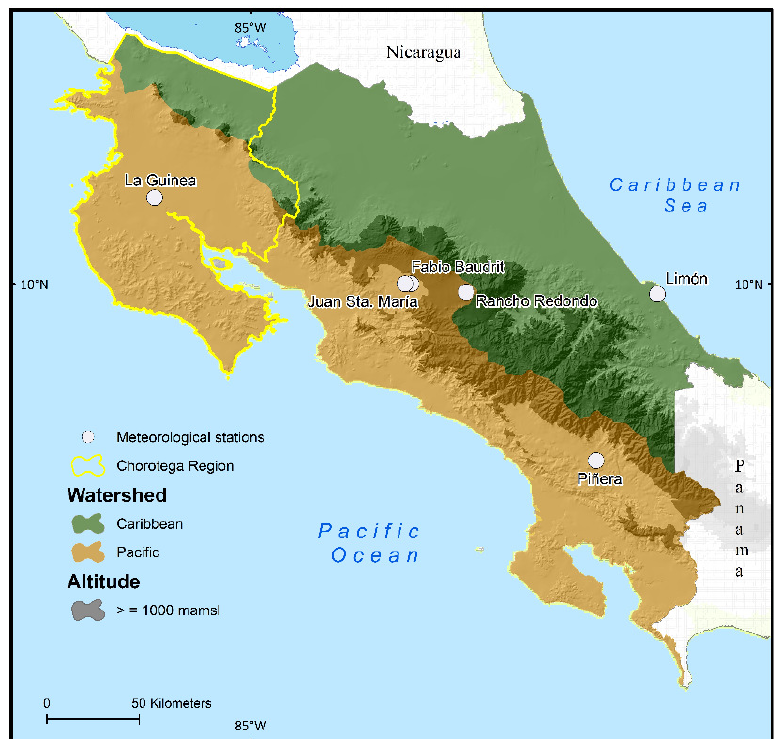
Figure 1. Location map of surface meteorological stations over Costa Rica. Digital elevation model from Ortiz-Malavasi [85]. Table 3. Meteorological stations metadata and their climatological (1970–1999) basics data. A: